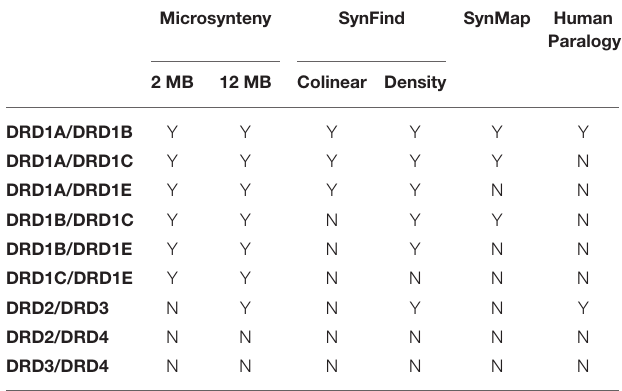
TABLE 2 | Duplication evidence summary. TABLE 3 | Reference receptor